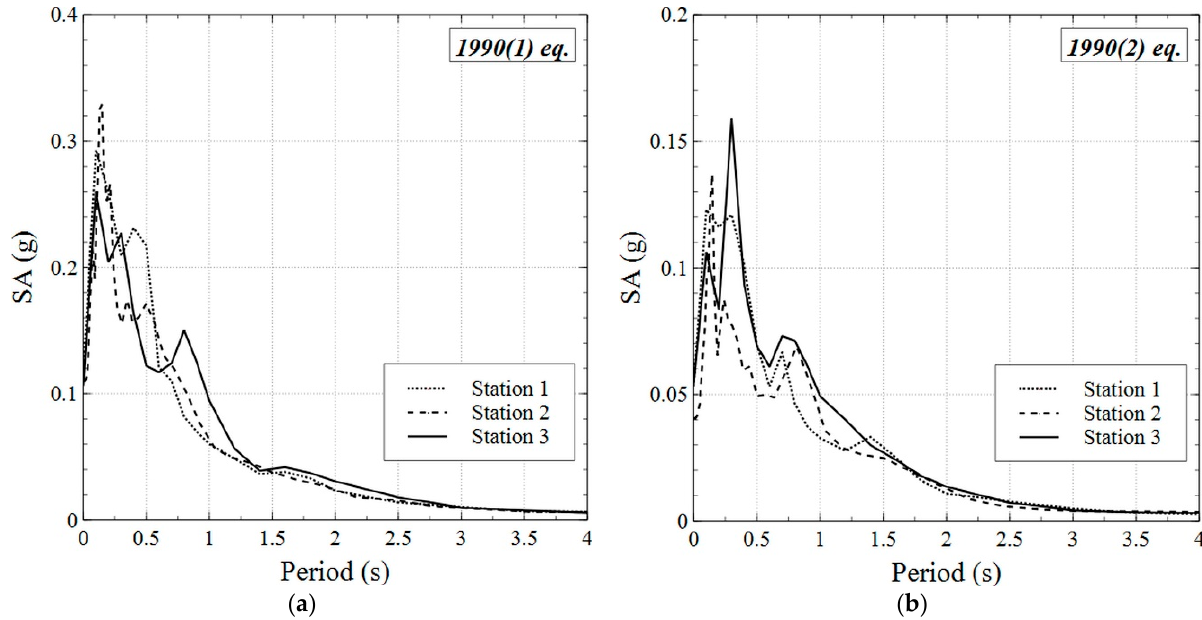
Figure 13. Comparison between the GMRotD50 response spectra of the ground motions recorded at two seismic stations in Iasi area during: ( a ) the 1990(1) Vrancea earthquake; ( b ) the 1990(2) Vrancea earthquake.